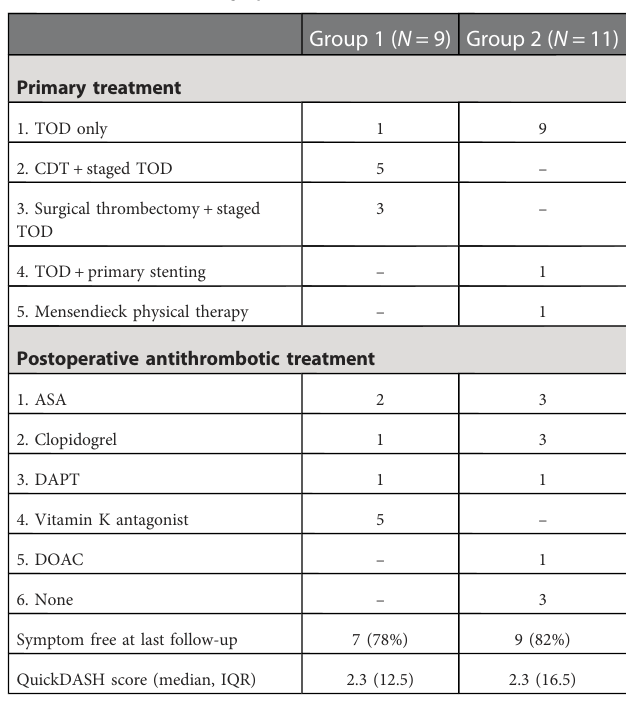
TABLE 2 Treatments, and symptom free survival. TABLE 1 Baseline